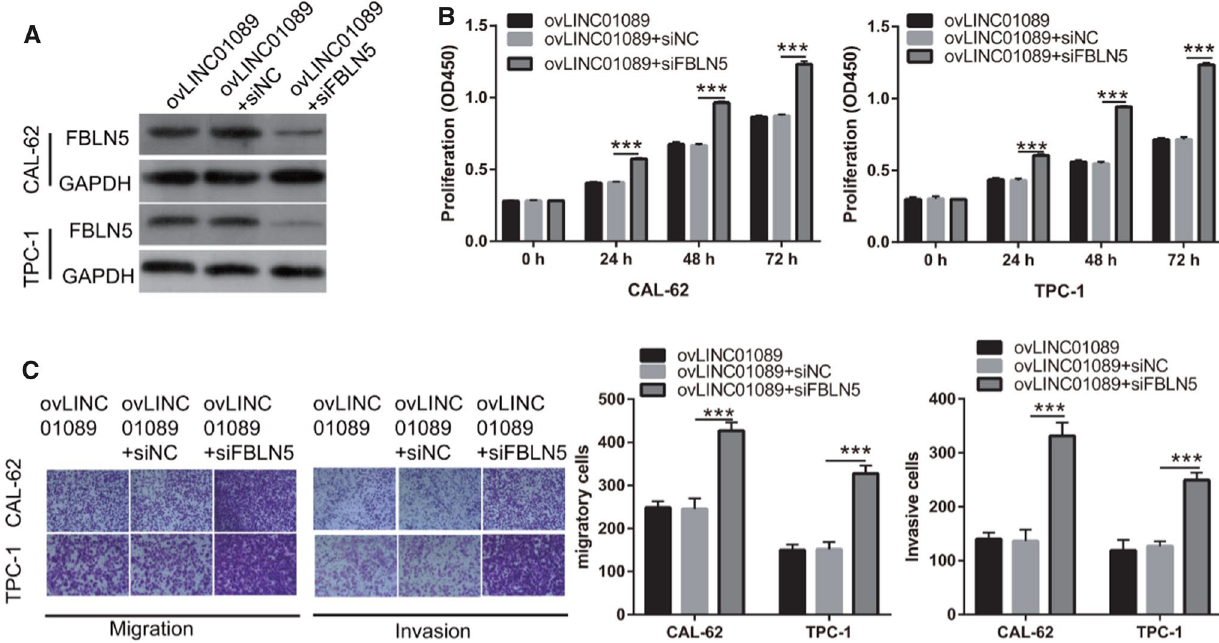
Fig. 6 FBLN5 silence promoted the malignant progression potential of ovLINC01089-transfected thyroid cancer cells. A FBLN5 protein in TPC-1 and CAL-62 cells was measured via western blotting after co-transfection of ovLINC01089 and siFBLN5. B Proliferation was evaluated by the CCK-8 assay after co-transfection. C Migration and invasion were assessed by the Transwell assay after co-transfection (magnification, 100×). Histograms represent the mean ± SD (n = 3). ***p <